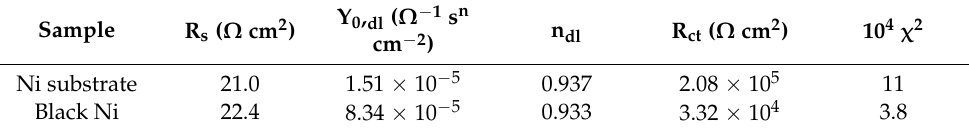
Table 5. Parameters obtained from the impedance spectra in Figure